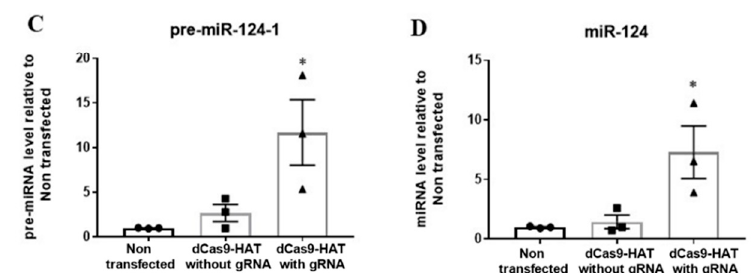
Figure 6. Delivery of histone acetyltransferase to miRNA-124-1 gene locus increases miRNA-124-1 gene transcription in human PH-Fibs. ( A ) Schematic presentation of how to make a plasmid that express 4 different gRNAs. ( B ). Schematic presentation of our histone acetyltransferase targeting system consistent of two components, a fusion protein between nuclease-activity deficient Cas9 (dCas9) and p300 HAT activity, and four gRNAs (expressed from the plasmid diagramed in ( A )) that will deliver the dCas9-HAT protein to the transcription start regions of miR-124-1 gene. ( C , D ) qRT-PCR detection of pre-miR-124-1 ( C ) and mature miR-124 ( D ) in human PH-Fibs ( n = 3) transfected with indicated plasmid(s). Data are presented as mean ± S.E.M, * p < 0.05 vs. Non